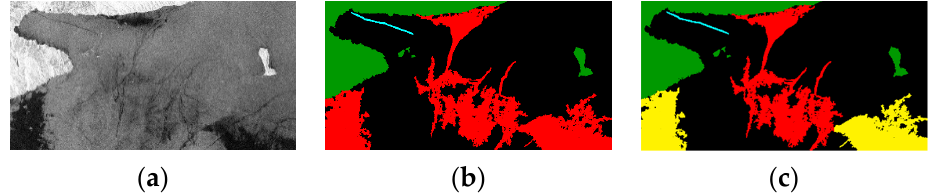
Figure 15. ( a ) Satellite image; ( b ) single ‘Oil Look-Alike’ type (red); ( c ) two ‘Oil Look-Alike’ types (red as Sharp and yellow as Patch Look-Alike).